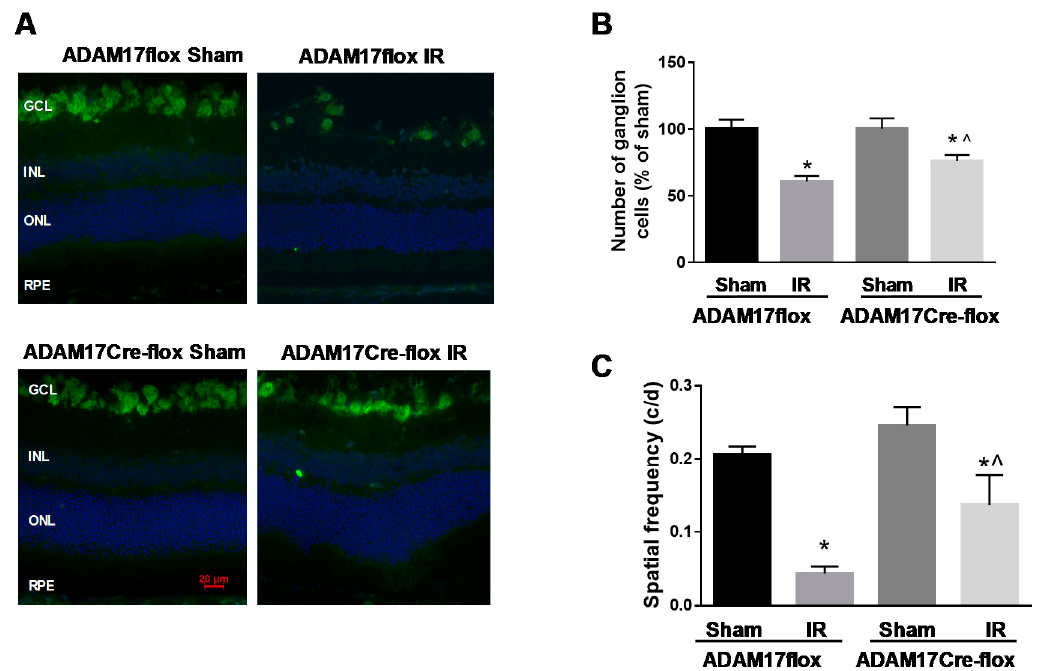
Figure 4. IR-induced ganglion cell loss is decreased in mice with conditional inactivation of endothelial ADAM17. ( A ) Representative immunofluorescence images of retinal cryosections from control ADAM17flox and ADAM17Cre-flox mice 7 days after ischemic insult identifying retinal ganglion cells (RBPMS-positive cells; green). Nuclei were stained with 4 ′ ,6-diamidino-2-phenylindole (DAPI; blue). Scale bar, 20 µm. ( B ) Quantification of RBPMS-positive cells. Data are expressed as cell number/100 µm retinal length and presented as a percent change from sham. * p < 0.01 vs. corresponding sham. ^ p < 0.05 vs. ADAM17flox IR; n = 5 in each group. ( C ) Visual acuity is improved in mice lacking endothelial ADAM17. Optokinetic tracking response was measured in control ADAM17flox and ADAM17Cre-flox mice subjected to IR using the OptoMotry system. Data are shown as mean ± SE. * p < 0.05 vs. corresponding sham; ^ p < 0.05 vs. ADAM17flox IR; n = 5 for each group.